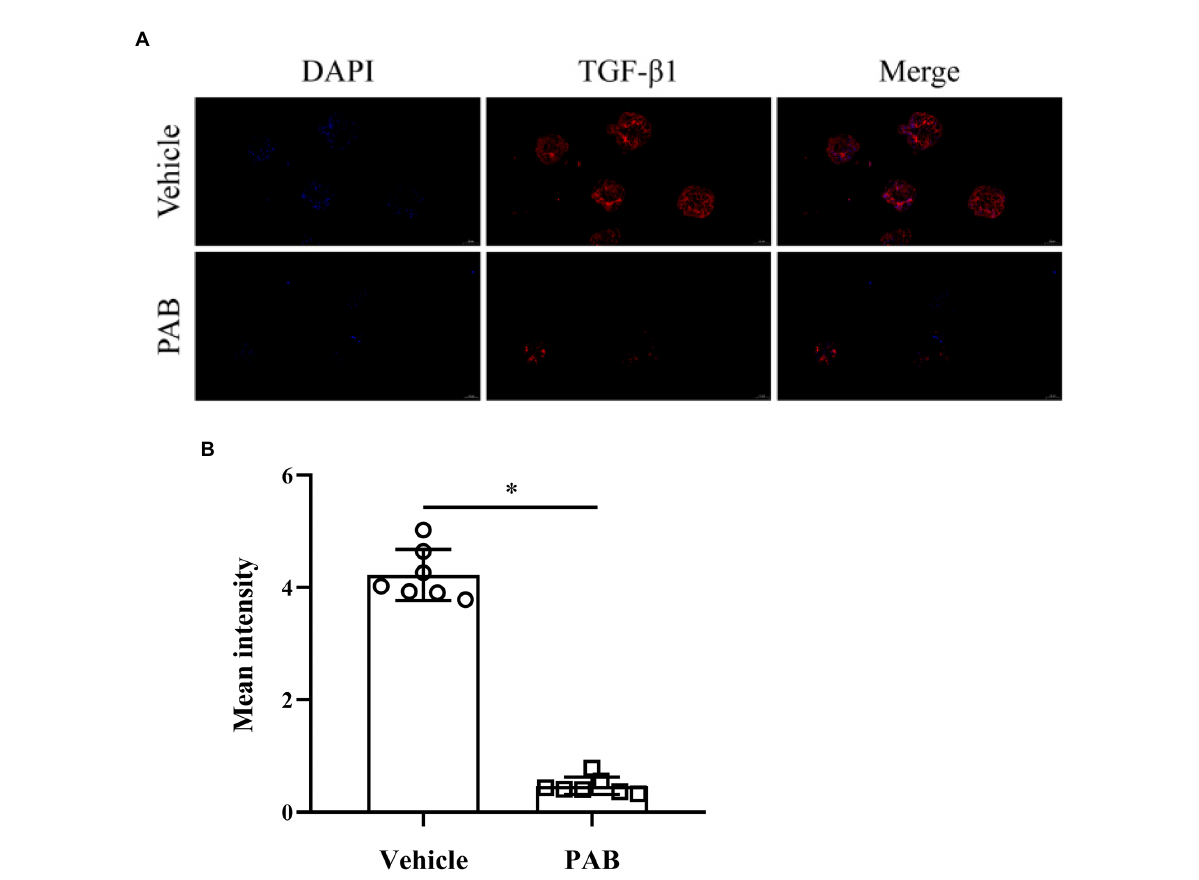
FIGURE 4 Expression of TGF- β 1 in E. multilocularis PSC after treatment with 20 μ g/ml PAB for 2 days by immunofluorescence assay. (A) Location of TGF- β 1 protein (red) and DAPT-indicated DNA (blue) in the PSC in immunofluorescence staining images. Scale-bars: 50 μ m. (B) Analysis of mean fluorescence intensity indicated TGF- β 1 protein expression, as measured by ImageJ software. The data was assessed using t